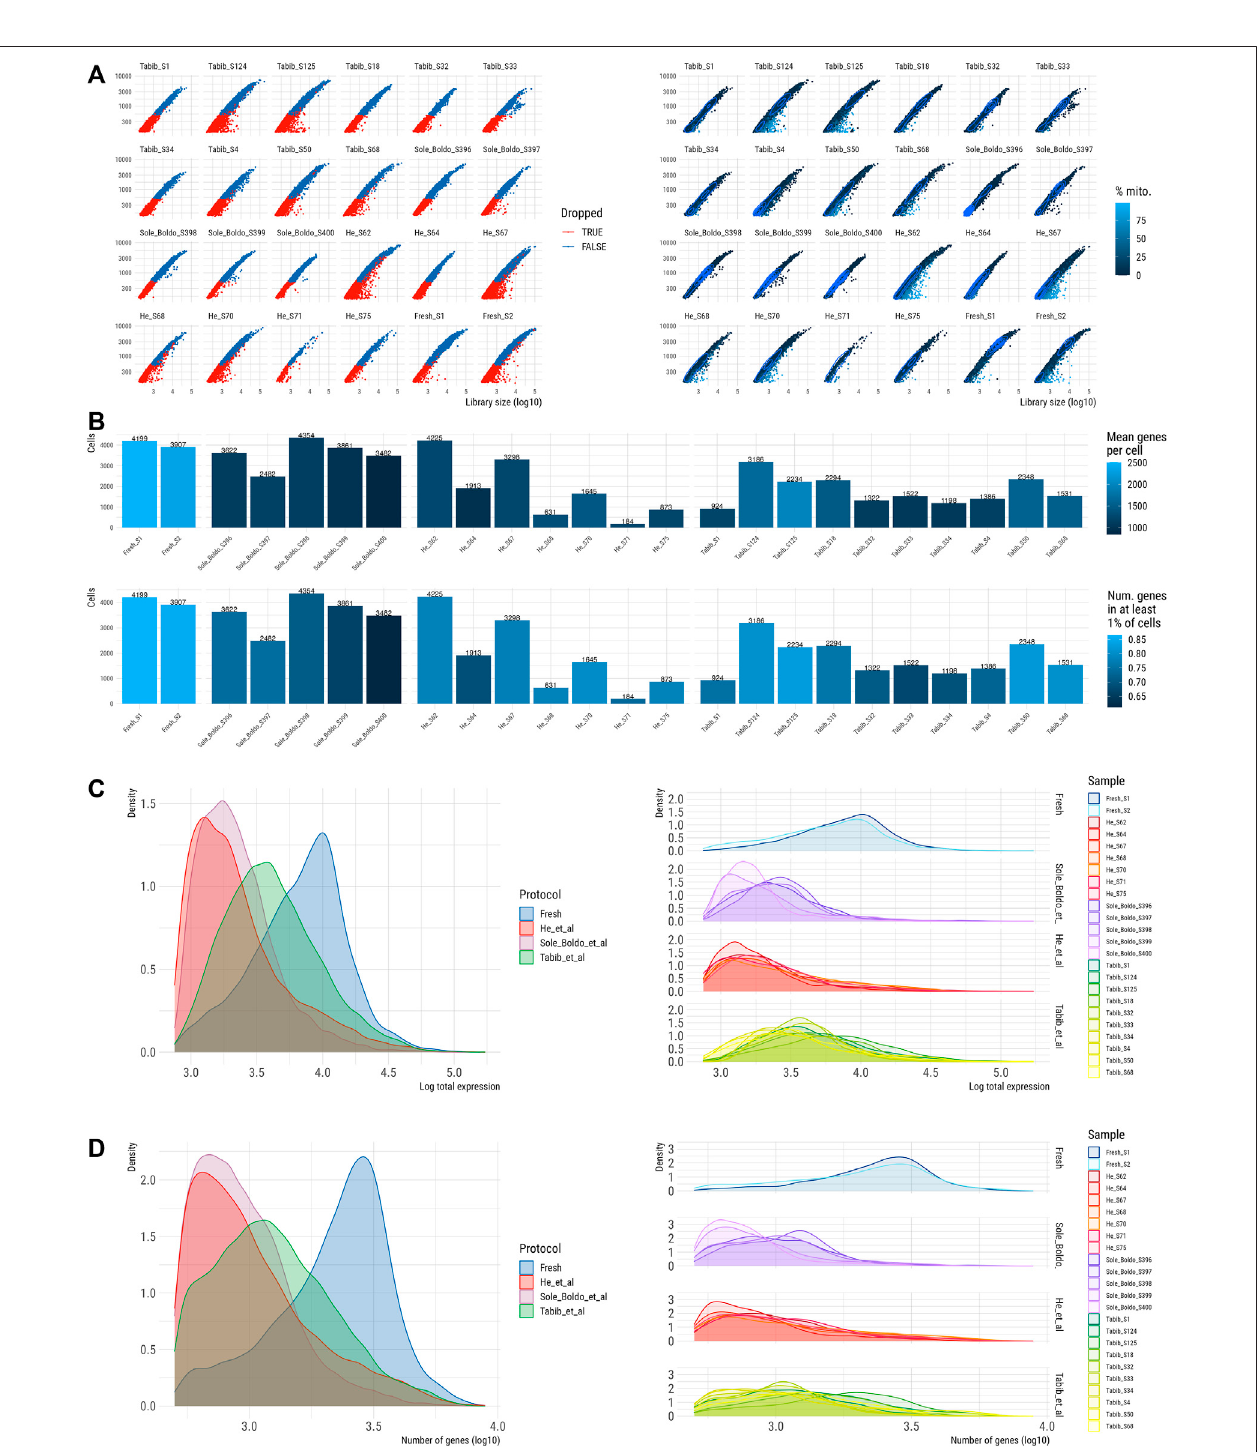
FIGURE 4 | QC of skin scRNA-seq dataset prior to normalisation and batch correction (A) . Library size (x-axis) vs. number of genes per sample coloured by fi lter (left) and percentage of mitochondrial counts (right). (B) Number of cells per sample coloured by number of genes (top) and by number of genes in at least 1% of cells (bottom). Distribution of counts (C) per protocol (left) and per sample (right). Distribution of number of genes (D) per protocol (left) and per sample (right).